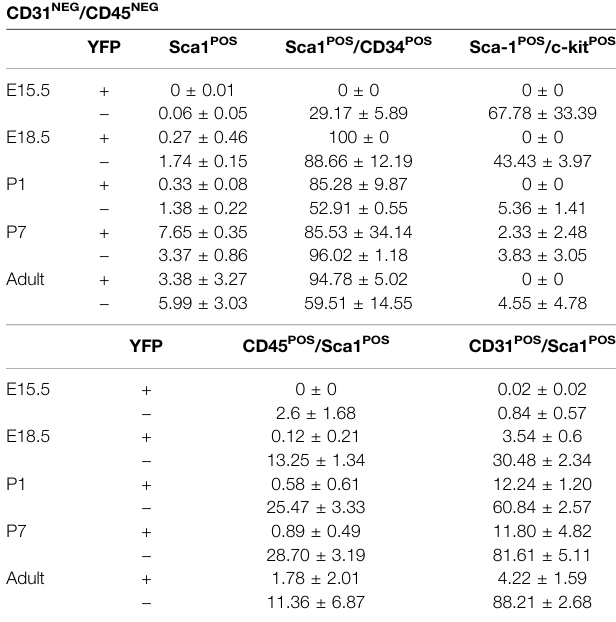
TABLE 2 | Percentage of Sca1 POS cells included in both YFP POS and YFP NEG fractions into the different characterized subpopulations (mean ± s.e.m.). CD31 NEG /CD45